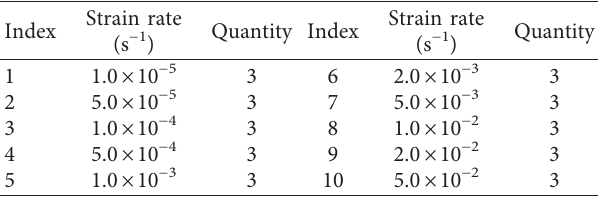
Table 2: Loading scenarios for uniaxial compression test.